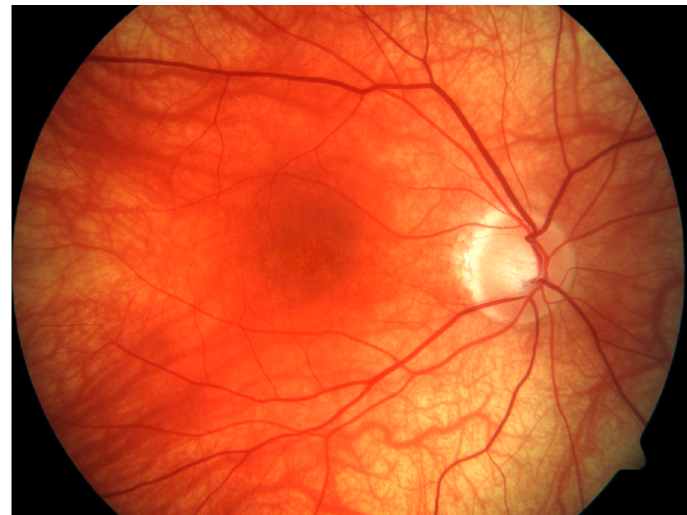
Figure 1. Typical sunset glow fundus of one patient included in the study: diffuse orange-red discoloration of the fundus with peripapillary atrophy and mottling of the pigment epithelium in the macular region.